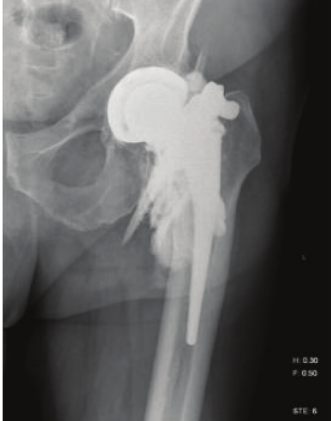
Figure 3: X-ray arthrogram showing mild contrast tracking along the proximal lateral aspect of the femoral component.